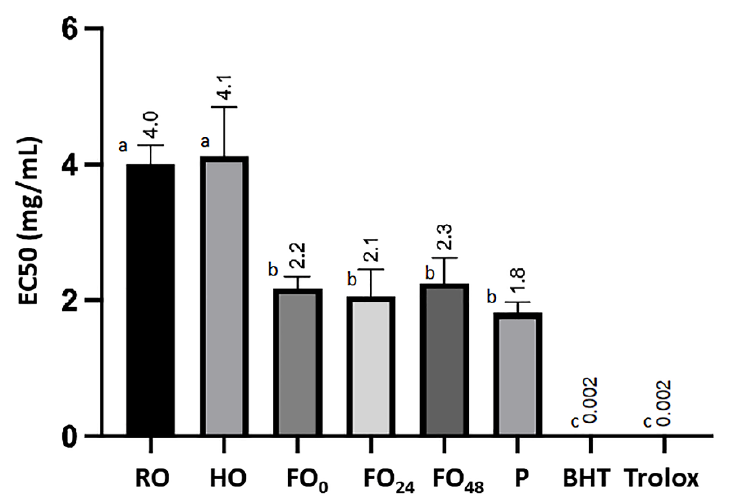
Figure 8. Antioxidant activity of raw (RO), hydrolyzed (HO), and fermented oatmeal samples obtained at time 0, and after 24 h, 48 h, and deactivation process (FO 0 , FO 24 , FO 48 , and P, respectively) and BHT and Trolox, expressed as the amount necessary to reduce the initial DPPH content by 50% (EC 50 ). Each result represents the mean value of a triplicate analysis and error bars indicate the corresponding standard deviations. Values marked with different lowercase letters are significantly different ( p < 0.05), according to Tukey’s test.